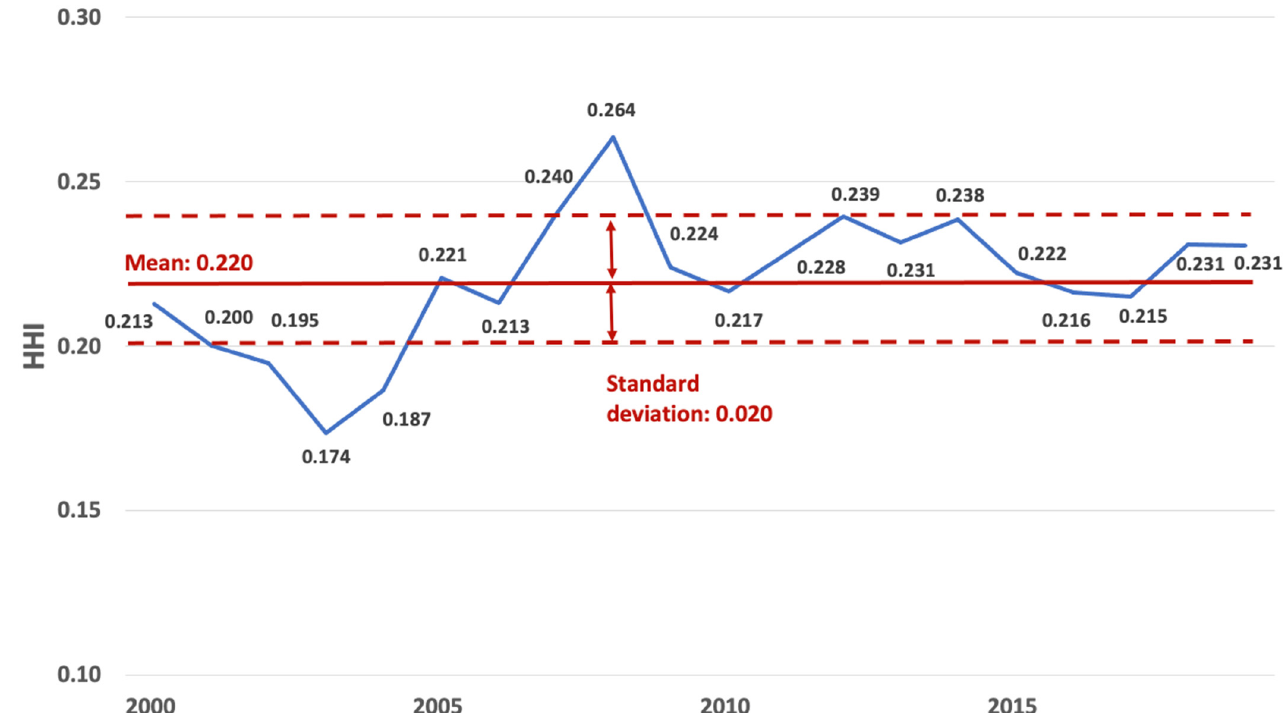
Figure 2. Export concentration of petroleum products.